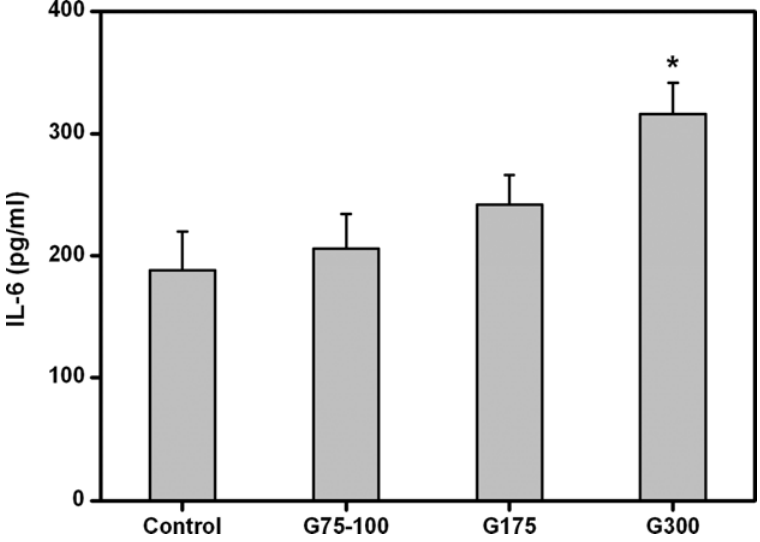
Figure 7. Level of IL-6 released from ARPE-19 cell cultures after incubation with various dissolved gelatin materials for two